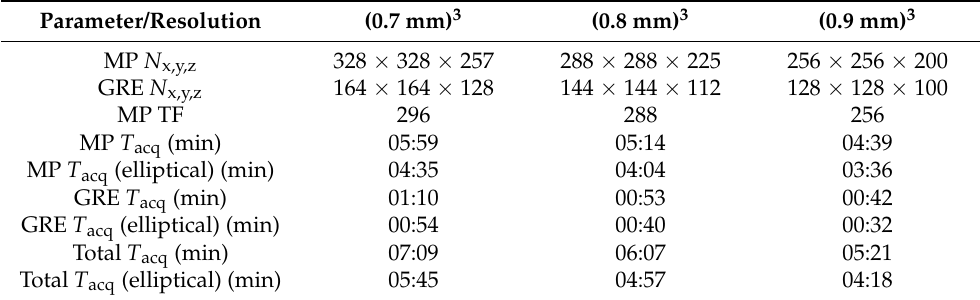
Table 1. Acquisition times ( T acq ) of the non-interleaved protocol at different spatial resolutions and with/without elliptical k-space phase encoding. The MPRAGE with (0.7 mm) 3 resolution used an inner loop SENSE AP = 1.11 to accommodate the readout